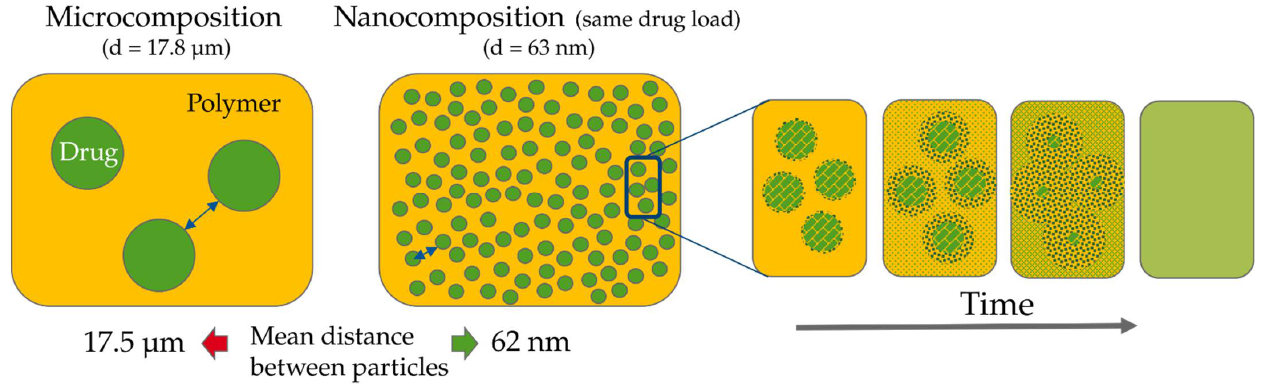
Figure 11. Distances of particles in the niclosamide micro- vs. nanocomposition with 20% DL on the left. The polymeric matrix is depicted in yellow. The green spheres correspond to the drug particles. The displayed distances correspond to the path length between the surfaces of the particles. On the right the dissolution and homogenization process are illustrated schematically.